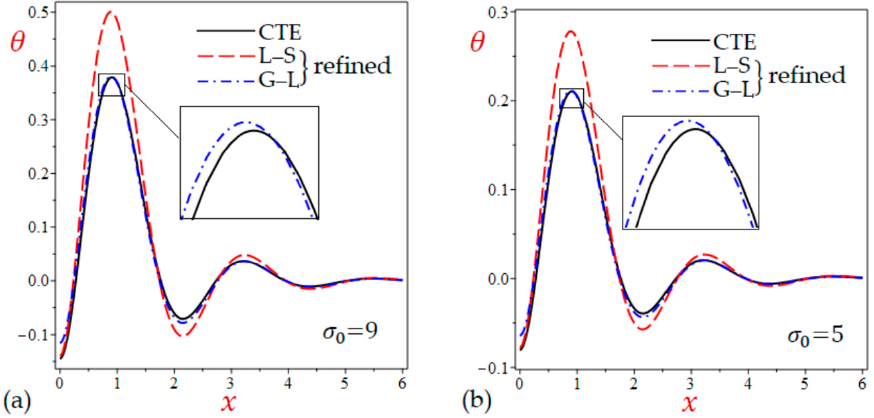
initial pressure ( 𝓅 = 10 ) ( a ) 𝜎 (cid:2868) = 9 ; ( b ) 𝜎 (cid:2868) = 5 .